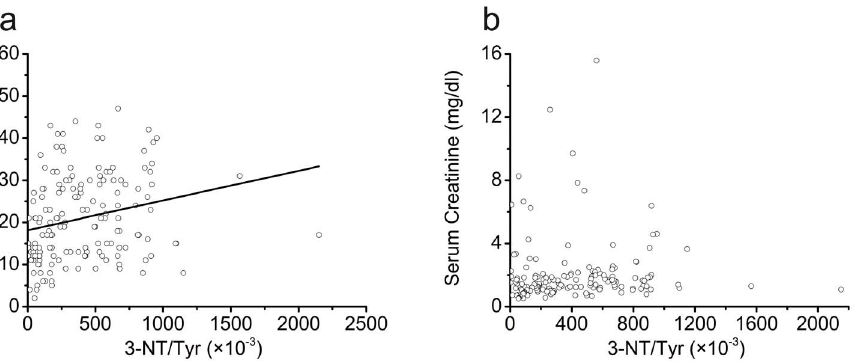
Figure 3. Correlations analysis of 3-NT/Tyr with APACHE II score and serum creatinine as AKI diagnosed in 158 patients with AKI. (a) correlation between 3-nitrotyrosine to tyrosine and APACHE II score, adjusted r 2 =0.048, p =0.003. (b) correlation between 3-nitrotyrosine to tyrosine